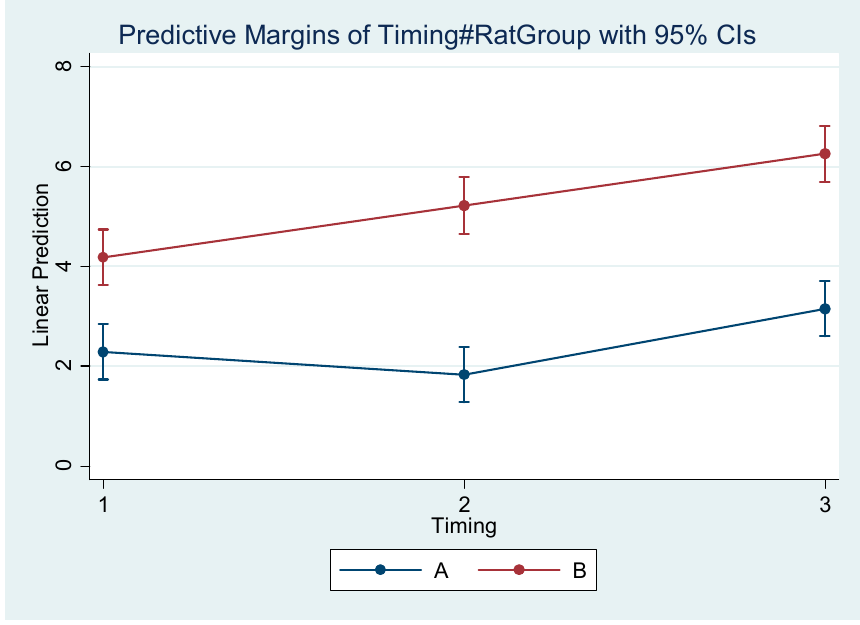
Figure 4. Estimated mean difference (Final–Initial) and 95% Confidence Interval per group and timing in Go’–Menton (mandibular body length a).